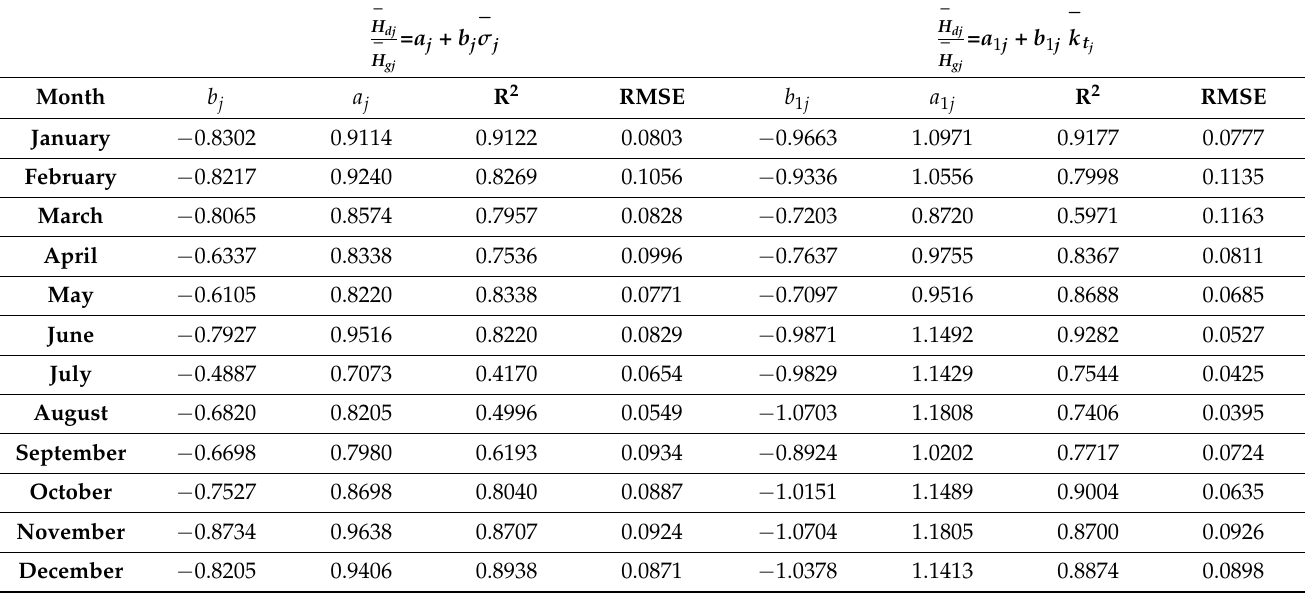
Table 2. Regression coefficients of the fit by the relation 1 and 2: